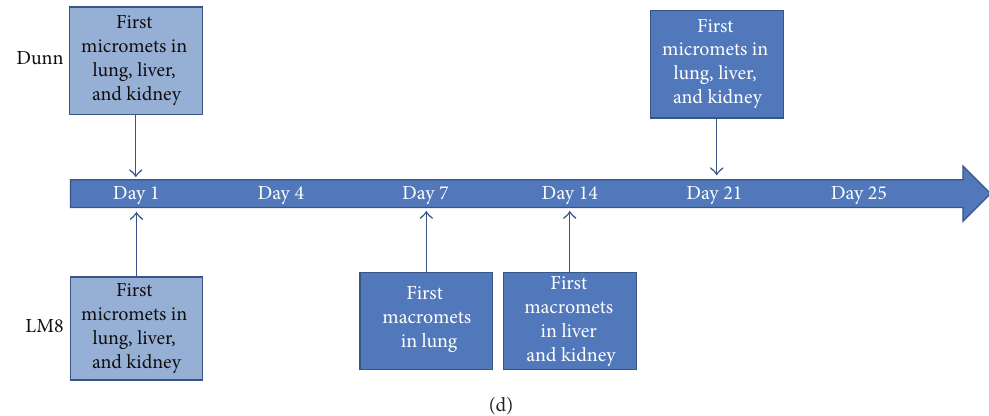
Figure 3: Appearance over time of experimental metastases in indicated organs after intravenous injection of lacZ -transduced Dunn and LM8 cells in C3H mice. ((a)–(c)) Images show X-gal-stained metastases in blue in representative whole mounts and ((a), (b)) corresponding close-ups of lungs (a), livers (b), and kidneys (c) collected from mice that were sacrificed at indicated time points after tumor cell injection. (d) Schematic summary of the first appearance of micro- and macrometastases ( > 0.1mm) over time in indicated organs.